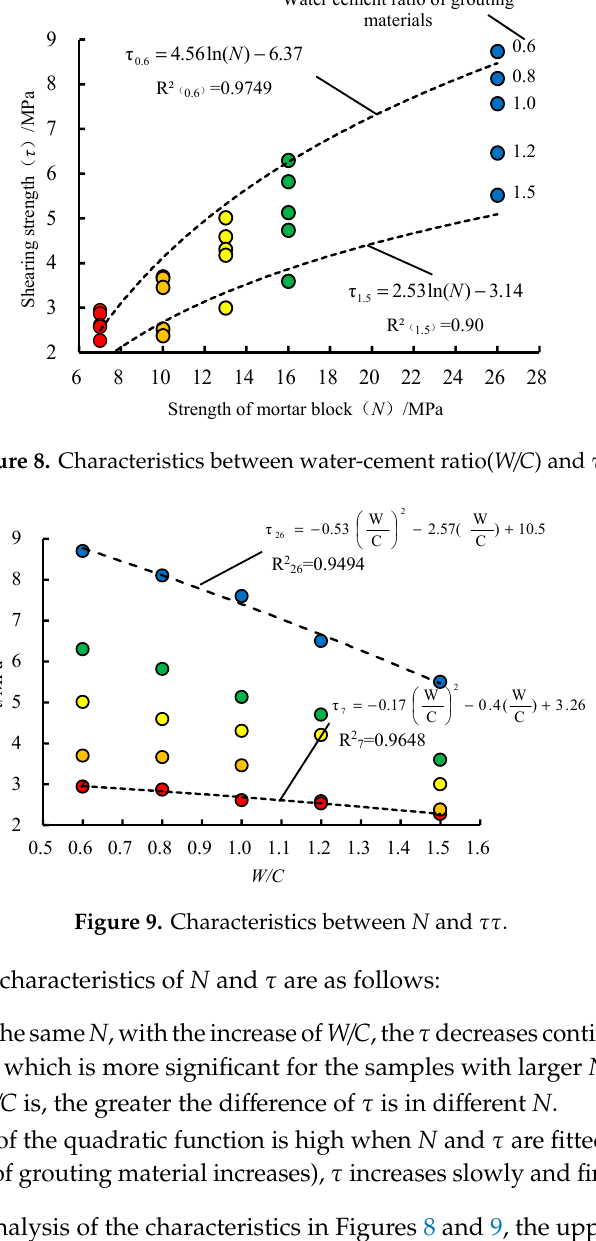
Figure 8. Characteristics between water-cement ratio( W/C ) and ττ .